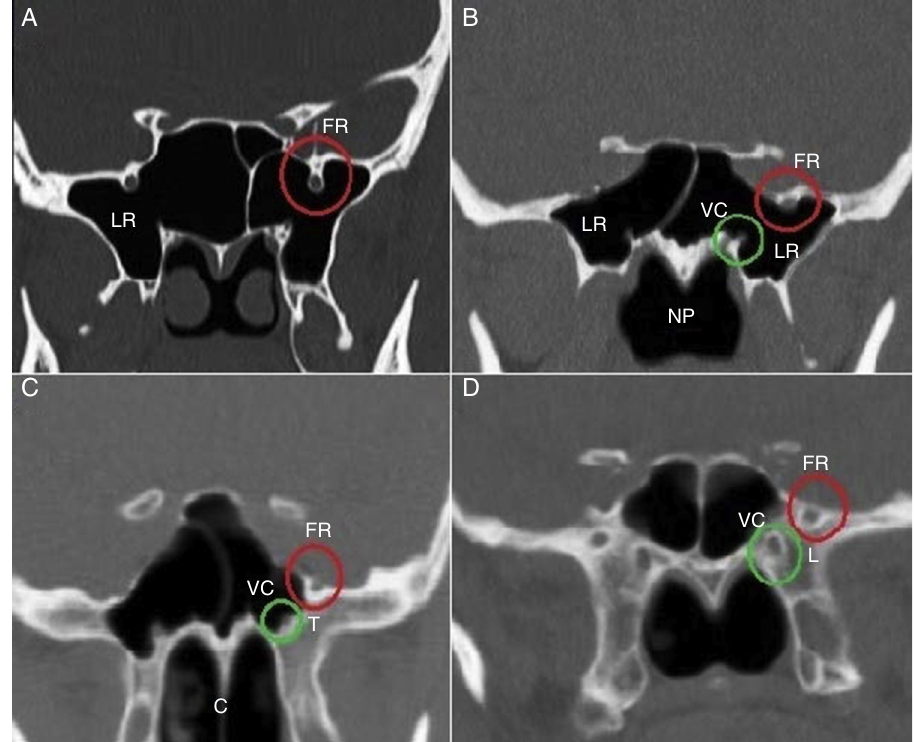
Figure 4 Foramen rotundum (FR), vidian canal (VC) and sphenoid sinus (SS) pneumatization classifications. A, FR type I and SS lateral recess (LR); B, FR type IIa, VC type I and SS lateral recess (LR); C, FR type IIb, VC type II and SS left side tangent (T); D, FR type III, VC type III and SS less pneumatized (L). NP, nasopharyngeal; C,